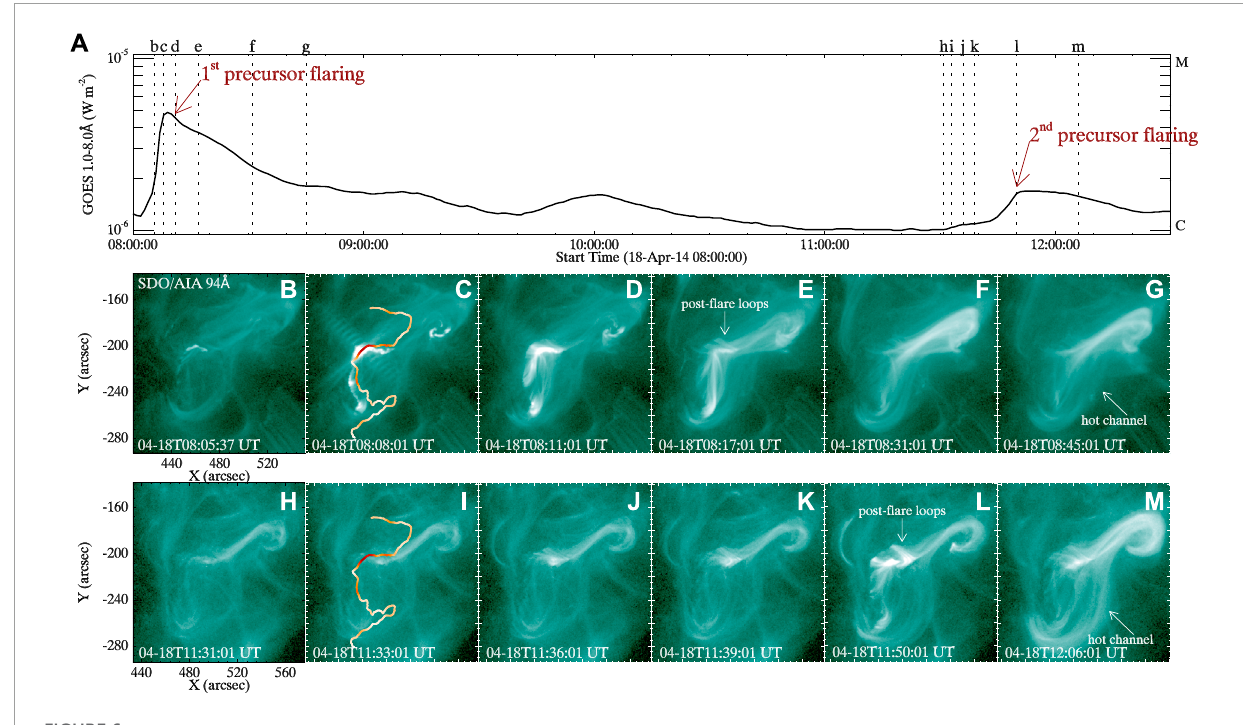
FIGURE 6 Two precursor small flarings prior to the M7.3-class flare. (A) Light curve of the GOES 1-8 Å flux during the two precursor flarings. Vertical-dashed lines mark the time of the EUV images shown. (B–G) SDO/AIA 94-Å images capturing the first precursor flaring. (H–M) SDO/AIA 94-Å images for the second precursor flaring. The colored curves in (C) and (I) are PILs, the color of which has the same meaning as those in Figure 3 . An associated animation ( Supplementary Video S3 ) is available online.